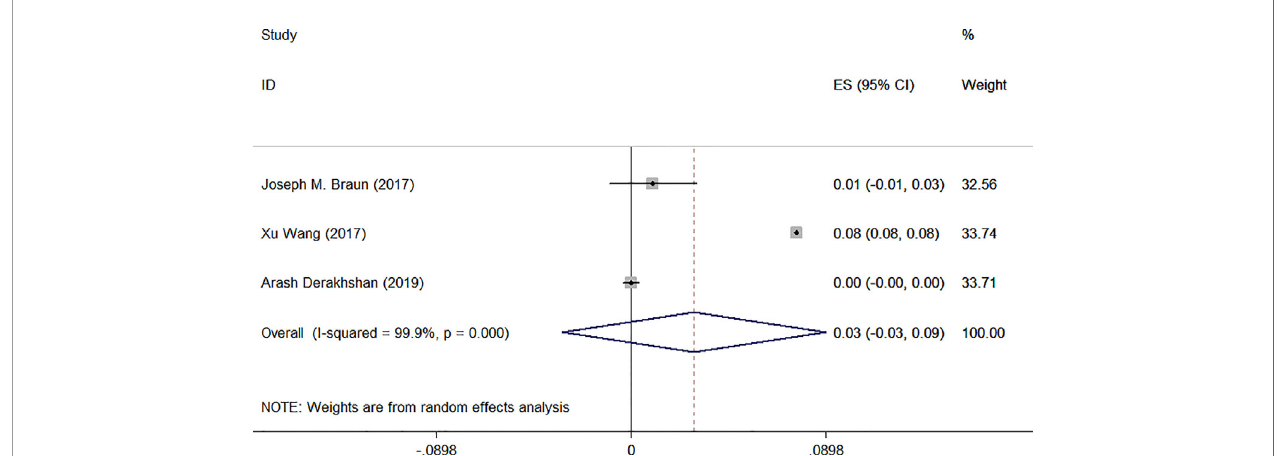
FIGURE 4 | Forest plot of prenatal exposure to TCS and maternal FT4 levels standardized using urinary